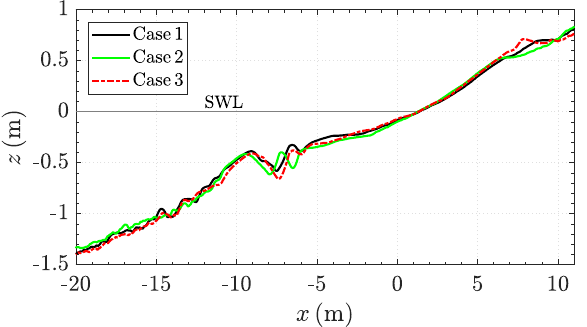
Figure 4. Final morphologies of the three